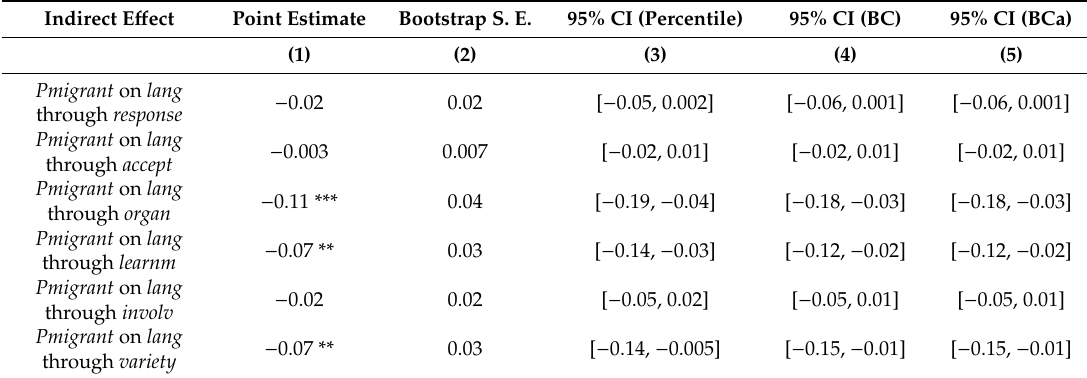
Table 5. Estimates of indirect e ff ects of parental migration on language development through di ff erent dimensions of home environment.